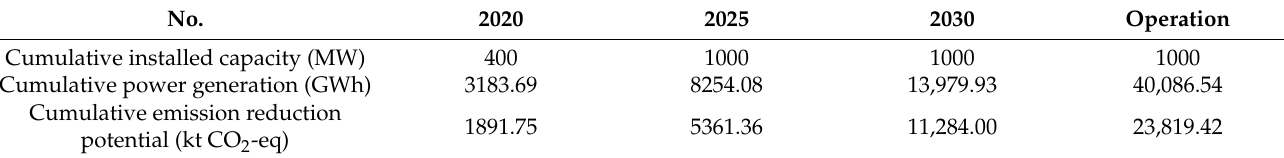
Table 3. Cumulative carbon emission reduction of photovoltaic power stations in